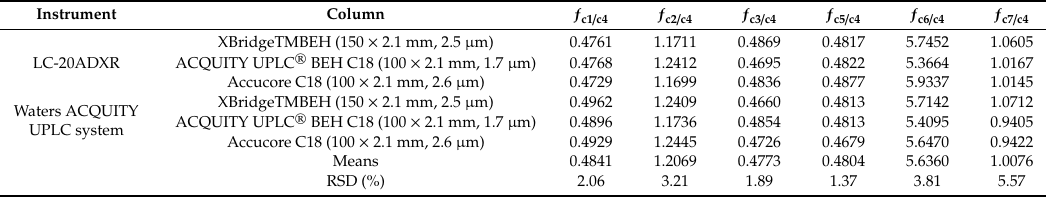
Table 5. RCFs in di ff erence instruments and columns.